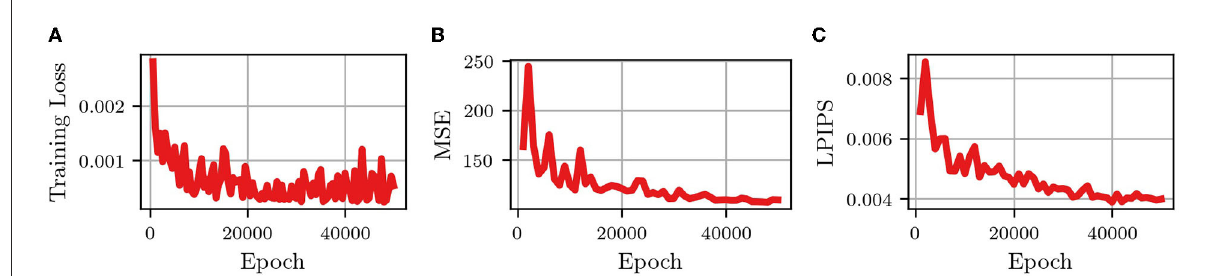
FIGURE3 Convergence metrics of predRNN (Wang et al., 2021) during training. (A) MSE loss for training images. (B) MSE loss for validation images. (C) LPIPS loss for validation images.